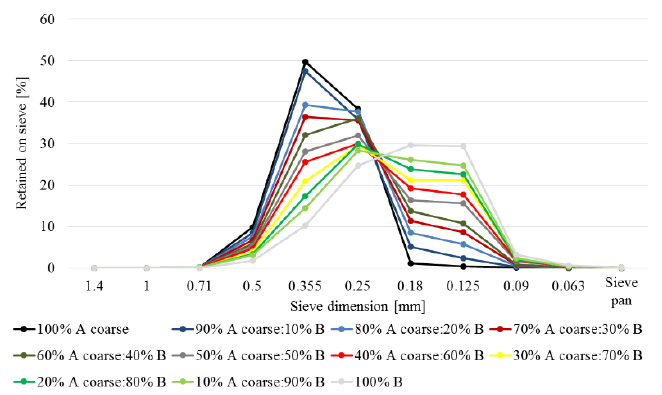
Figure 8. Grain size distribution curves for sands A coarse and B. Table 3. Basic properties of sands A coarse and B.